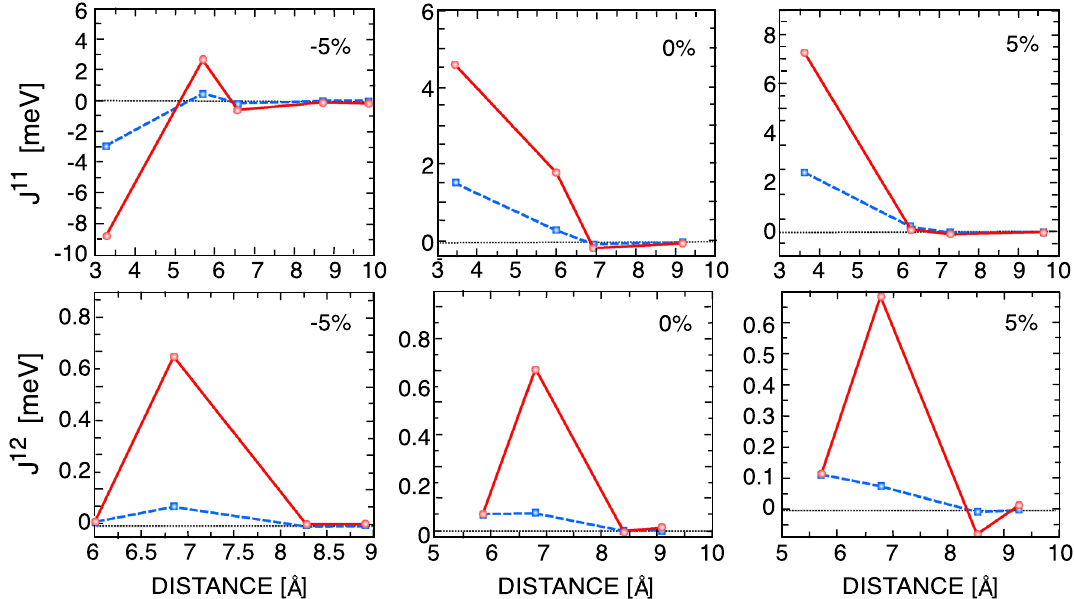
Figure 5. (Color online) Total intralayer (top panel) and interlayer (bottom panel) exchange parameters (dashed line) summed over all neighboring pairs of bilayer CrCl 3 (solid line) for unstrained (middle), -5 % strained (left) and +5 % strained (right) structures. A positive value indicates FM contribution, and a negative value indicates AFM